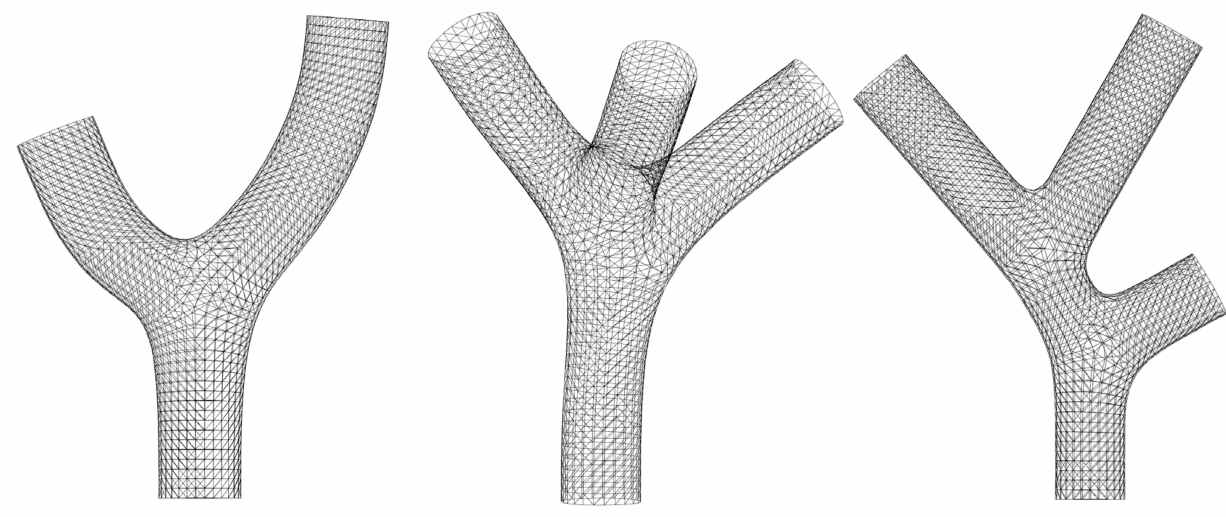
Figure 1. Three prototypes of input